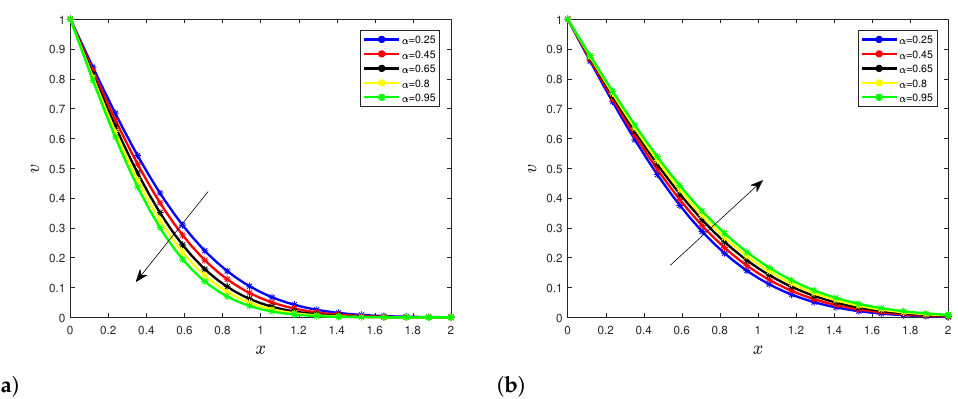
Figure 1. Dynamics of the fractional heat equation with various orders with respectively τ = 0.5 ( a ) and τ = 1.5 ( b ) for Pr = 1.